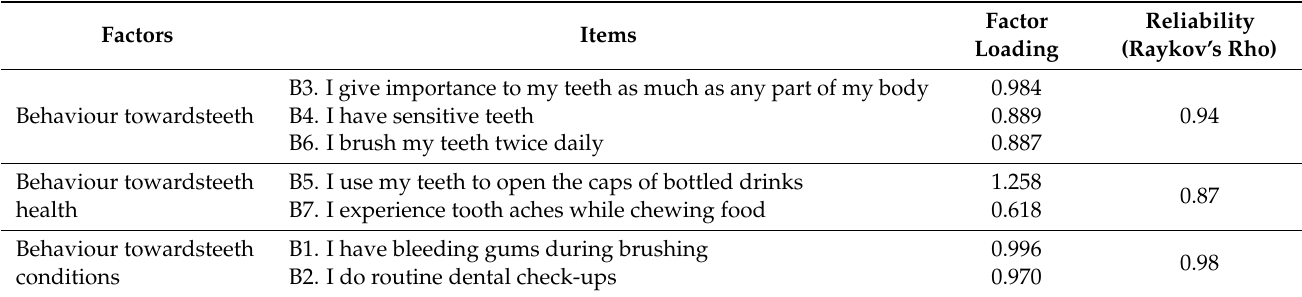
Table 6. CFA for behaviour domain.